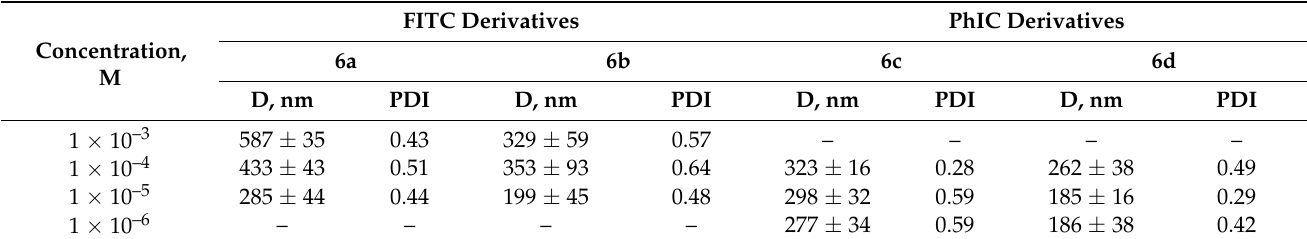
Table 1. Sizes of compounds 6a – d aggregates in water, obtained by the DLS